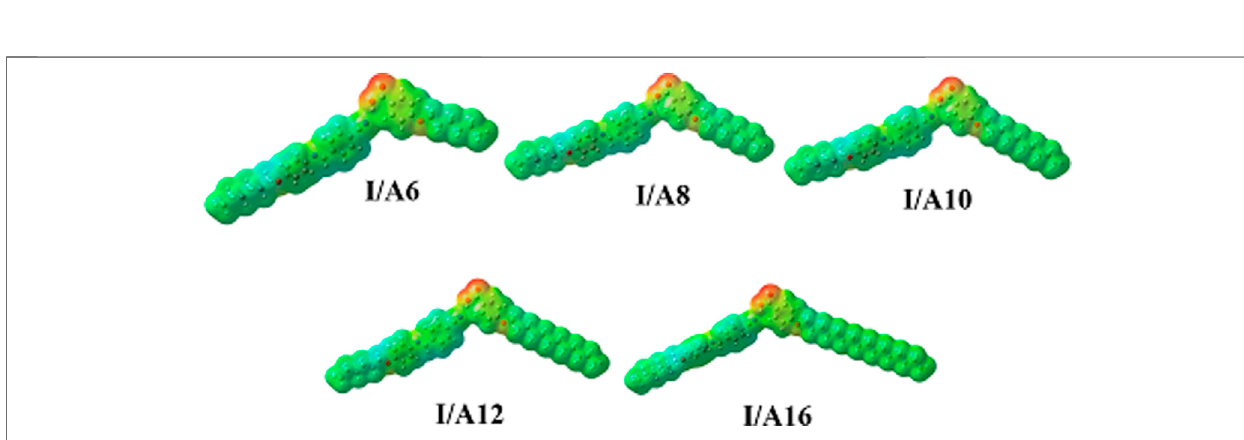
FIGURE 16 | Molecular electrostatic potentials (MEP) for SMHBCs